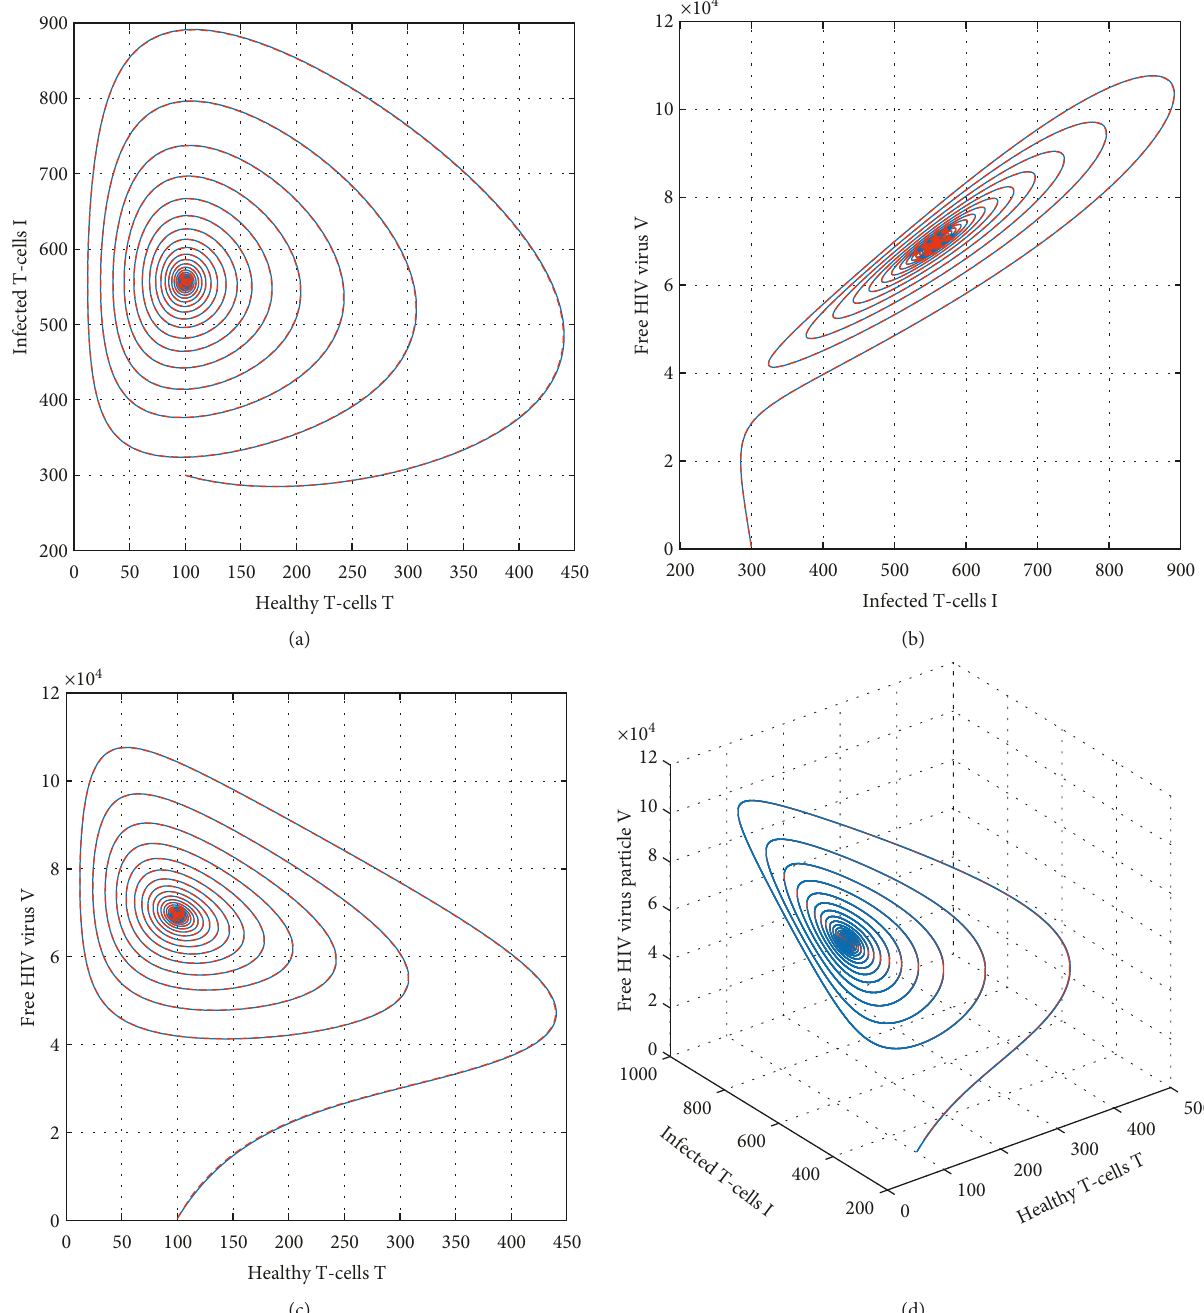
Figure 8: Graphical view analysis of the time series of the suggested fractional model (2) of HIV to represent its chaotic plot with the index of memory ϑ � 0 .